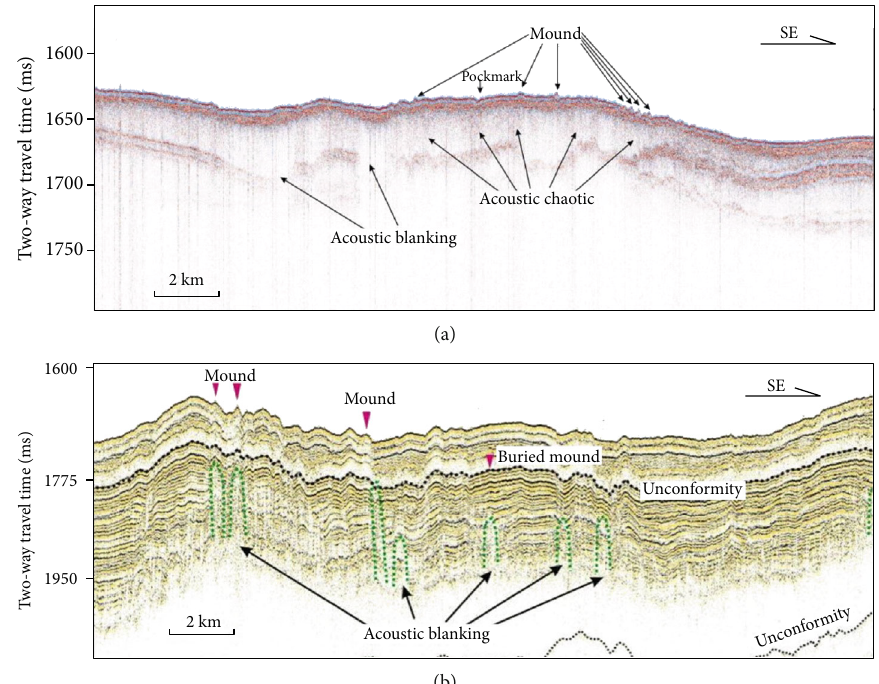
Figure 4: (a) Subbottom pro fi le and (b) seismic pro fi le showing the seabed microgeomorphological features related to gas seepage in the deep-water Qiongdongnan